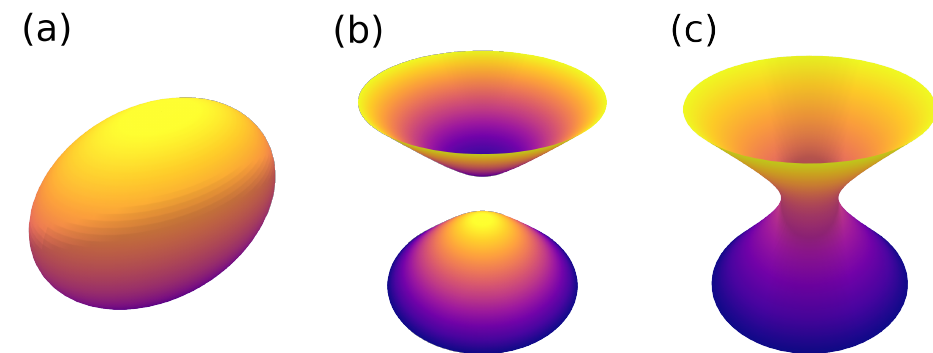
Figure 2. Possible isofrequency surfaces: ( a ) ellipsoidal, when (cid:101) xx > 0 and (cid:101) zz > 0, ( b ) type 2 hyperbolic, with (cid:101) xx > 0 and (cid:101) zz < 0, and ( c ) type 1 hyperbolic, with (cid:101) xx < 0 and (cid:101) zz >